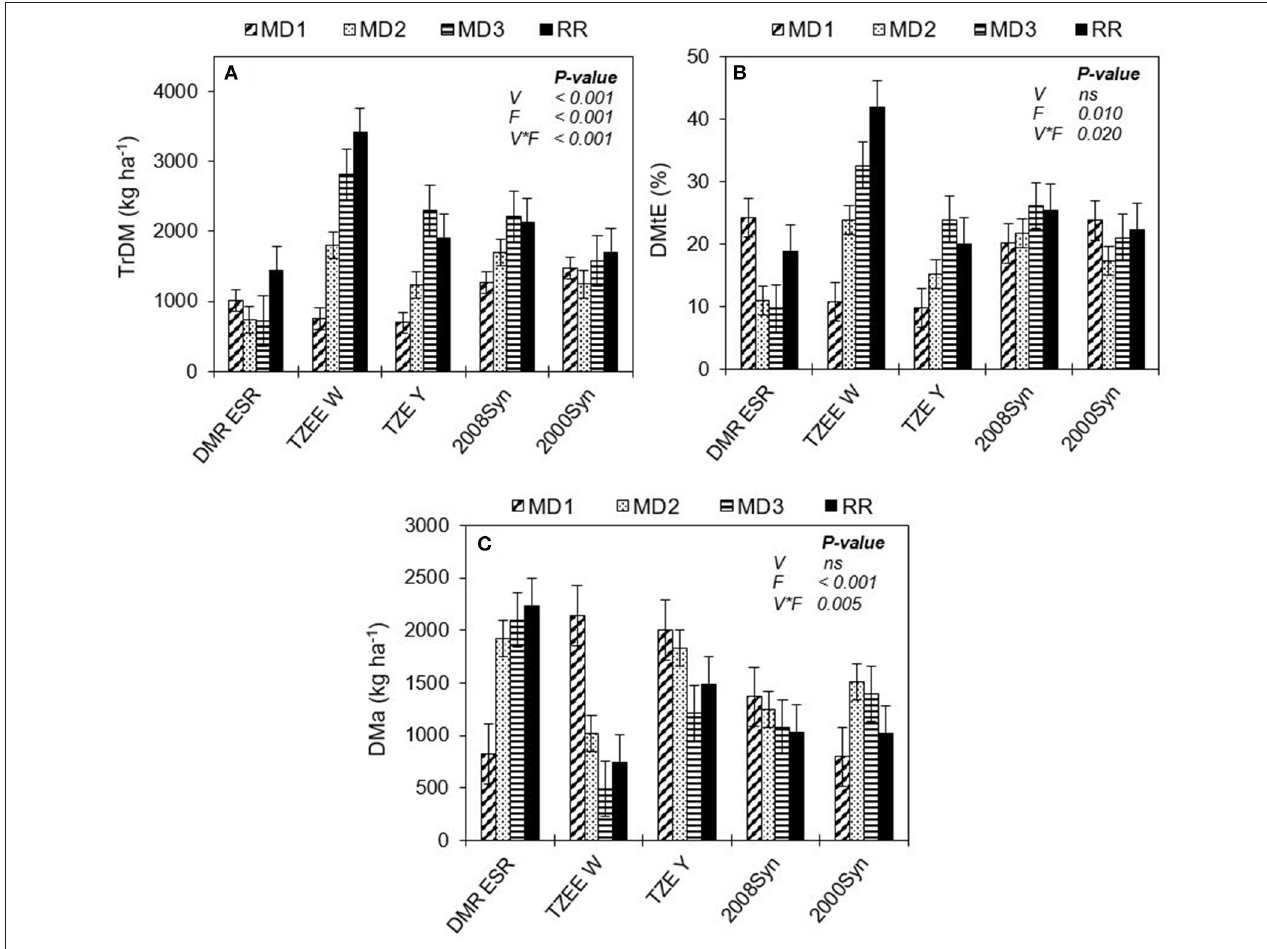
FIGURE 4 | (A) Tanslocation of DM accumulated before anthesis (TrDM), (B) the DM translocation efficiency (DMtE), and (C) the post-anthesis DM accumulation (DMA) as affected by the interactions between varieties and mineral fertilizer. Control refers to the absolute unfertilized treatment; MD1 (N25P4), MD2 (N25P8), MD3 (N35P8), and RR (N76P13) refer to fertilizer microdosing options 1, 2, and 3 and the recommended fertilizer rate, respectively. Error bars represent standard deviations. V, Variety; F, Fertilizer.